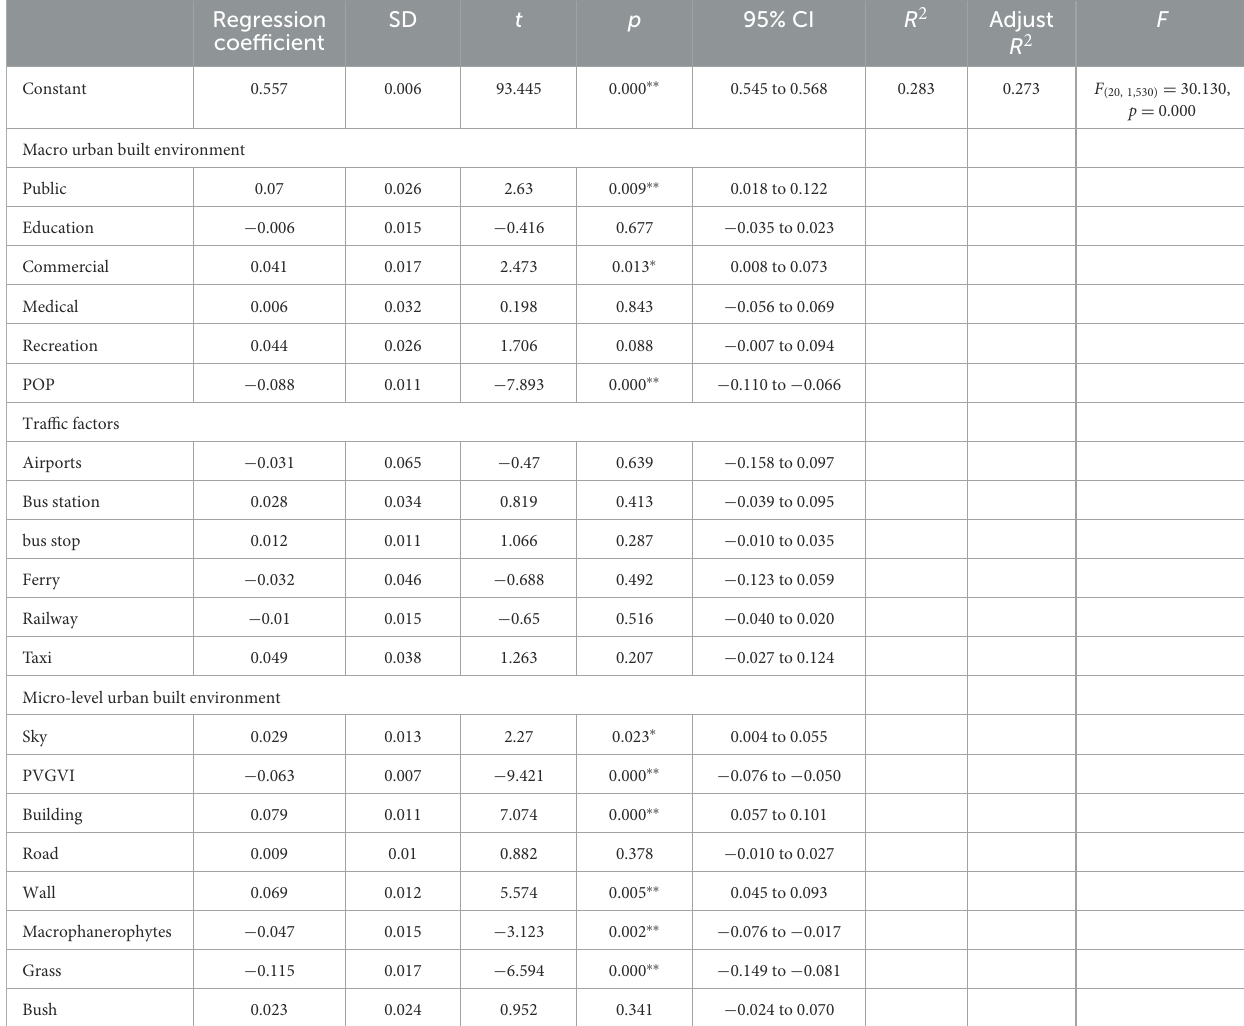
TABLE 5 Model 2: Robust regression results of CCR and urban built environment ( n = 1,551). Regression